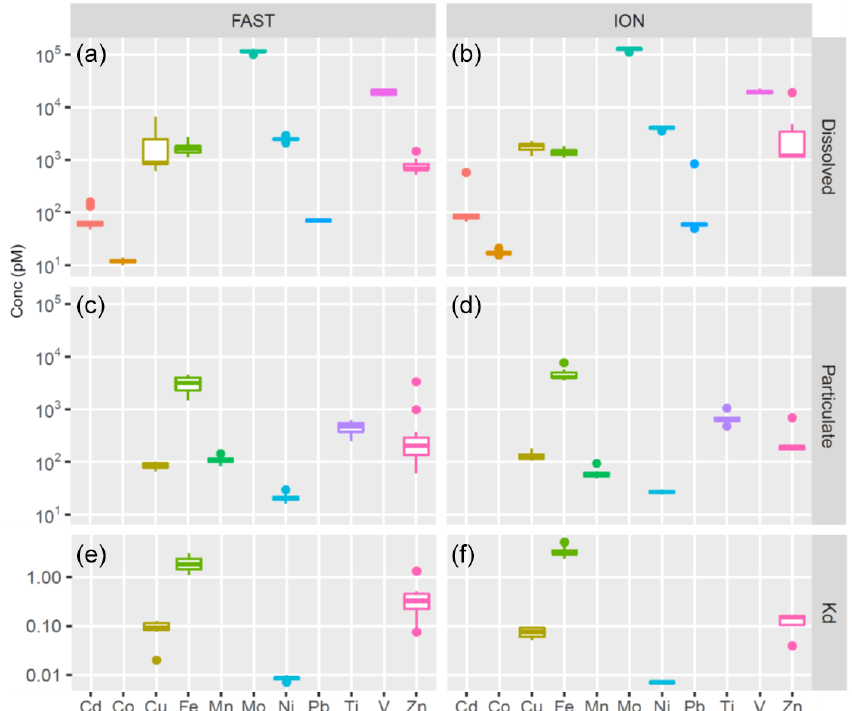
Figure 5. Box plots of dissolved (a, b) and particulate (c, d) marine concentrations (pM) and Kd values (e, f) for the different TMs within the ML at ION (b, d, f) and FAST (a, c, e) . In the box plots, the box indicates the interquartile range, i.e. the 25th and the 75th percentile, and the line within the box marks the median. The whiskers indicate the quartiles ± 1.5 times the interquartile range. Points above and below the whiskers indicate outliers outside the 10th and 90th